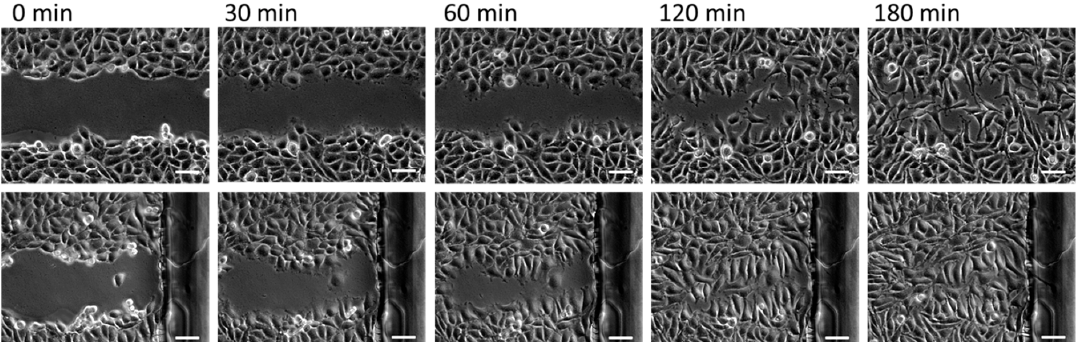
Figure 4. Representative images of time lapse microscopy of L929 mouse fibroblasts on thermoresponsive microgel lines in a microchannel (two different positions, first row and second row). The cell patterning was achieved by detachment of cells from the microgel lines after the sample was incubated for 30 min below the LCST at 22 °C. Cells attached on the uncoated areas remained on the substrate (first column). When the temperature was increased to 37 °C, the cells started to migrate to the now cell-free regions and formed a closed cell monolayer after 180 min (last column). Scale bars: 100 µm.